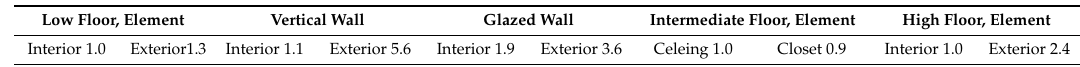
Table 2. Convective exchange coe ffi cients W / (m 2 K) for the